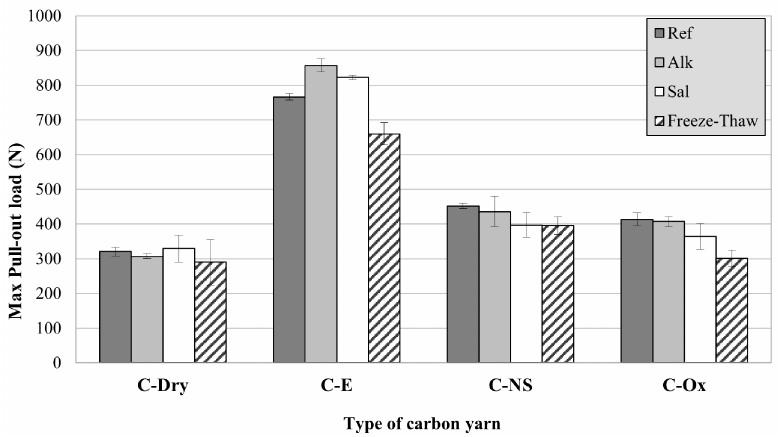
Figure 8. Pull-out load of carbon yarns with different surface treatments after artificial exposure.